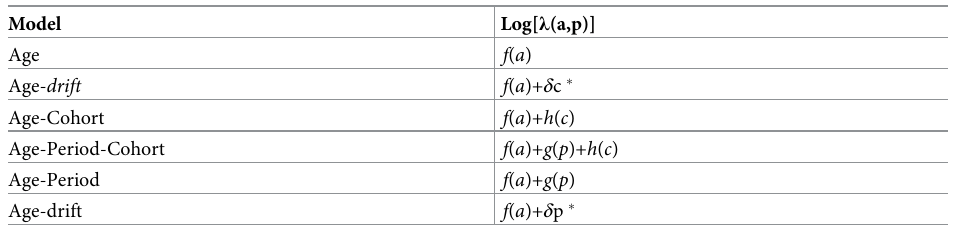
Table 3. Sequential structure of model comparison.